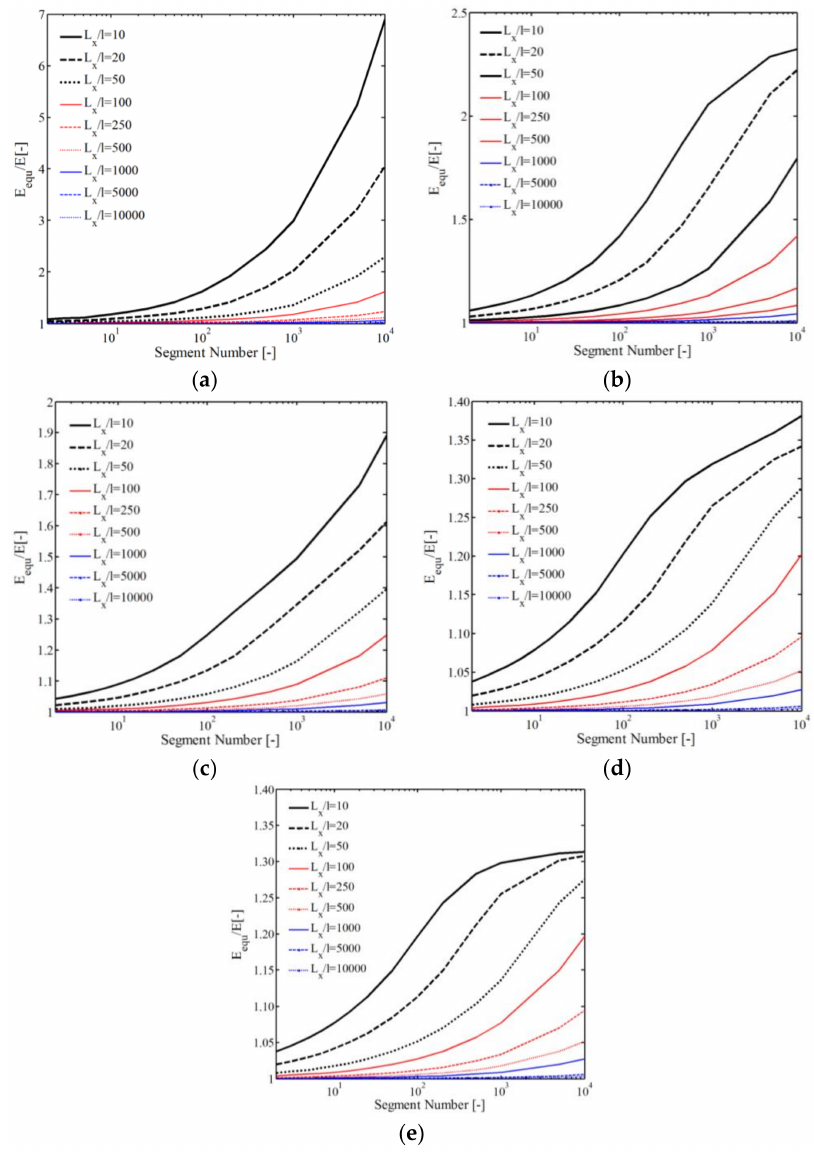
Figure 6. Effect of geometric effect on the equivalent elastic modulus: ( a ) L y / L x = 1; ( b ) L y / L x = 2;